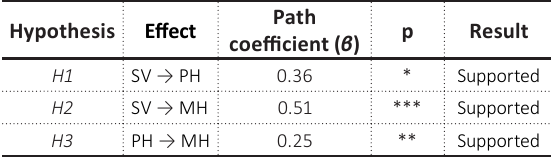
Table 4. Hypothesis